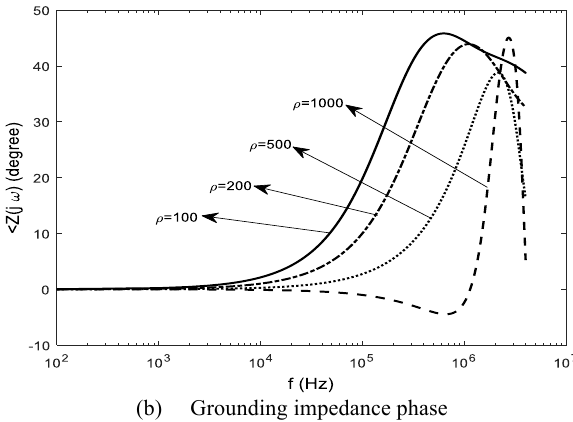
Figure 6: Variation of grounding impedance for different soil resistivity (rod length = 12m and relative permittivity ε =10) .